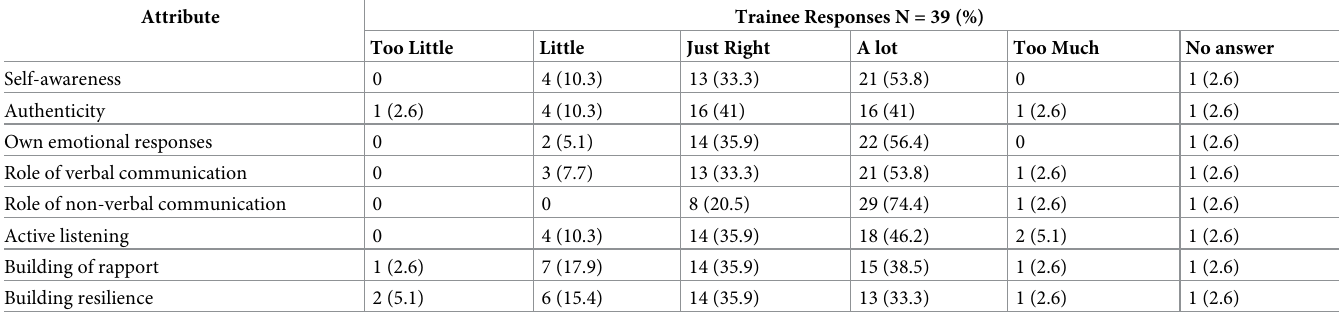
Table 6. Workshop coverage of key attributes for managing